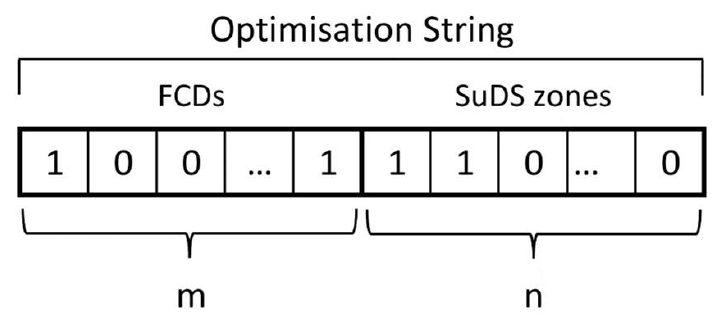
Figure 3. Binary optimization string representing a unique intervention scheme featuring FCDs coupled with SuDS zones; m and n are equal to the number of FCD locations and SuDS zones evaluated by the GA solver, respectively.